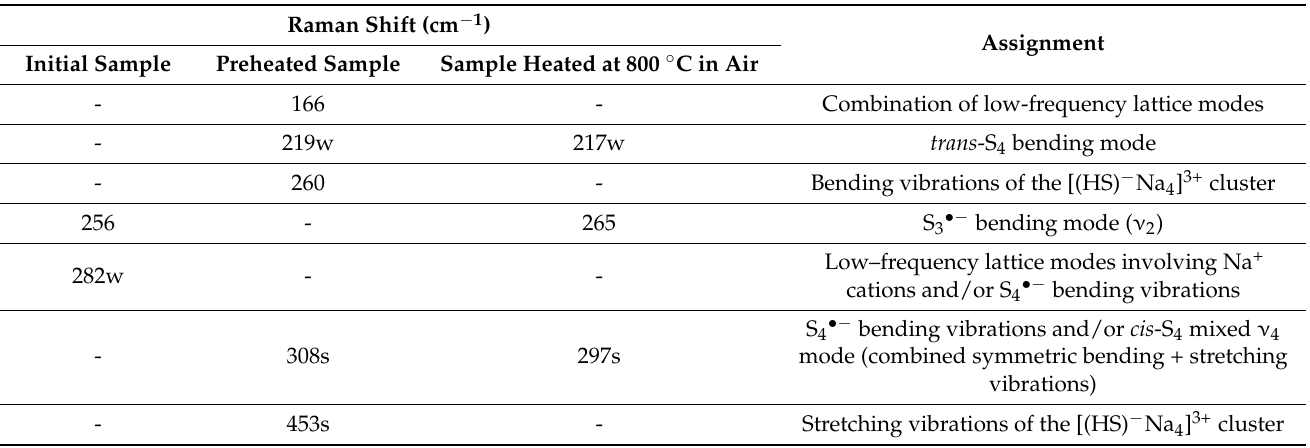
Table 4. Assignment of Raman bands of Sample 5 and products of its thermal